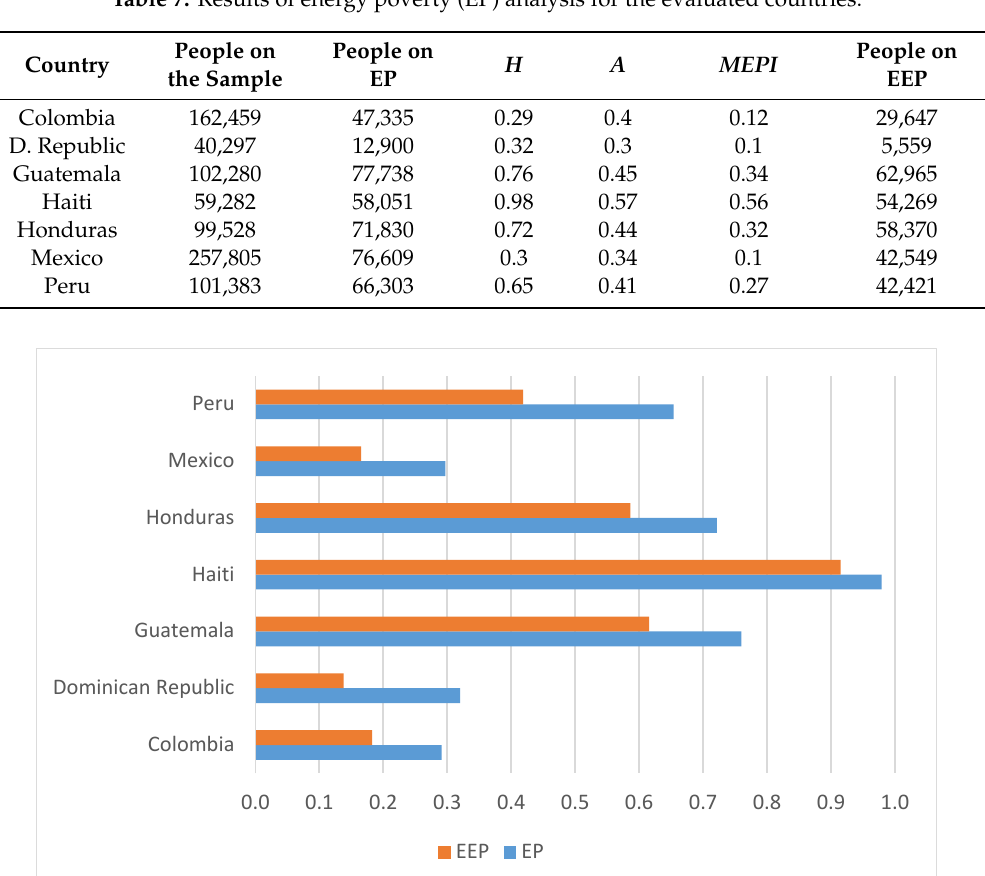
Table 7. Results of energy poverty (EP) analysis for the evaluated countries.